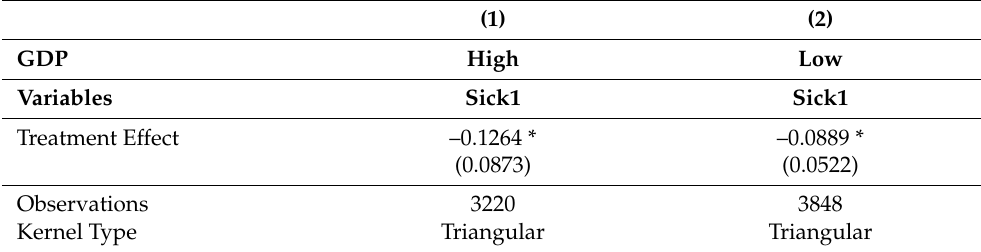
Table A2. Upstream–downstream health gap with different